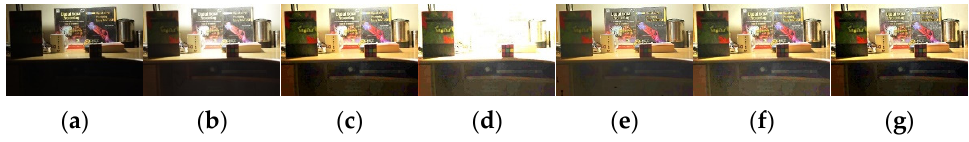
Figure 9. ( a ) Original image; ( b ) Reference. The remaining images are enhancement results, gener- ated by the following methods: ( c ) ALSM, ( d ) Li et al. [26], ( e ) LR3M, (f) LIME, and ( g ) the proposed method.